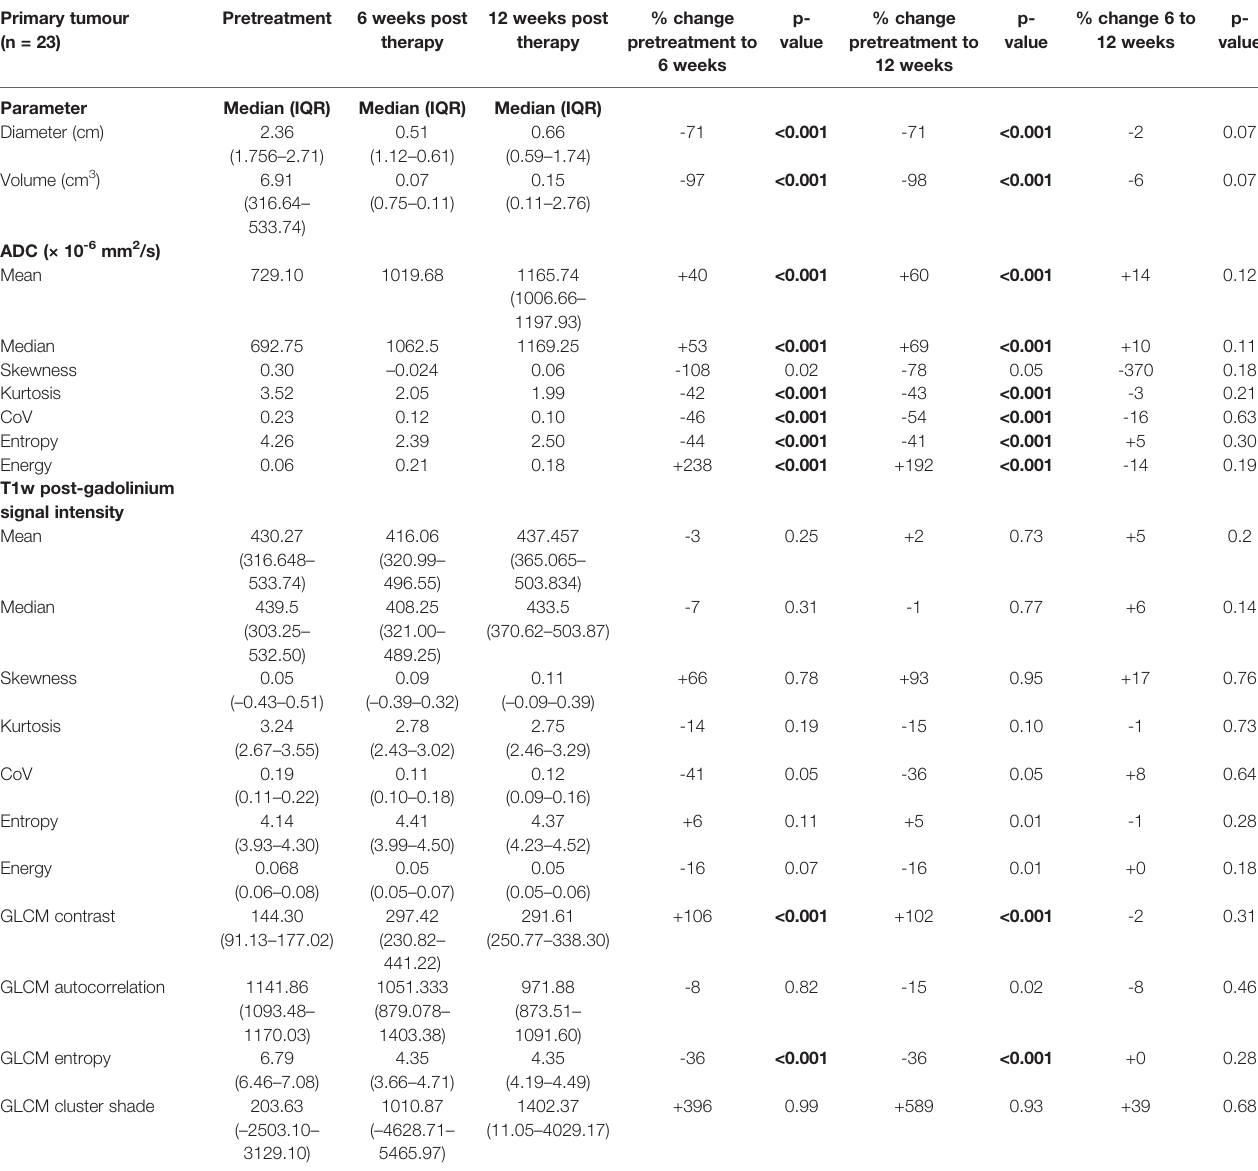
TABLE 2 | Pretreatment, 6-week post-CRT and 12-week post-CRT primary tumour ADC and post-gadolinium T1w histogram parameters and their interval changes with treatment (all with treatment success n =